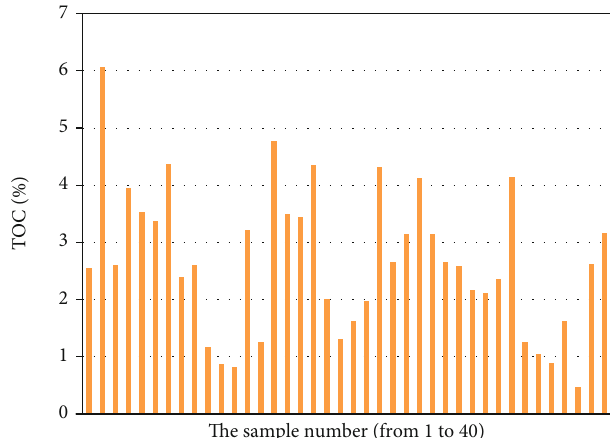
Figure 4: Histogram of the TOC distribution of the Longmaxi